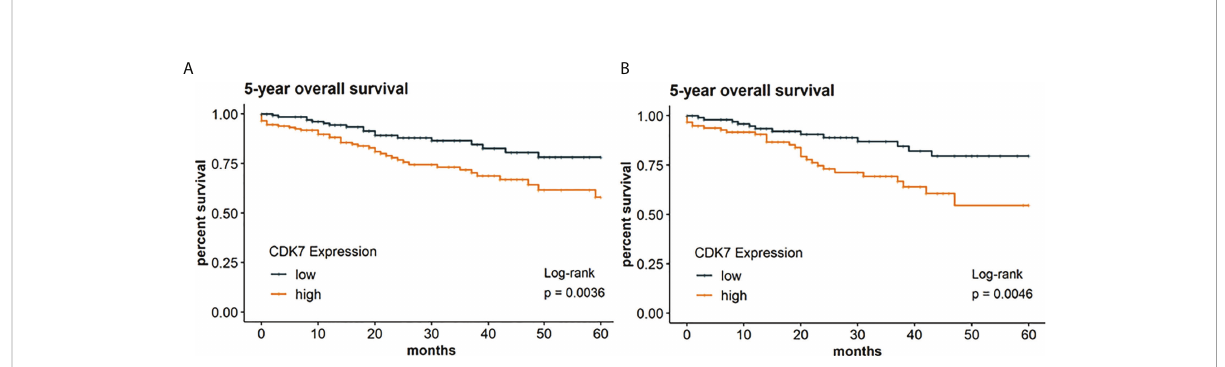
FIGURE 4 Kaplan Meier graphs with a p-value of Log-rank test of (A) 5-year overall survival of the whole cohort and (B) 5-year overall survival of the subcohort of adNSCLC. Median of CDK7 expression was used to stratify the cohort in two groups with expression above median considered as high expression and expression below median considered as low expression. Upregulation of CDK7 correlated signi fi cantly with a shorter OS for the whole cohort and group of adNSCLC (p=0.0036 and p=0.0046,